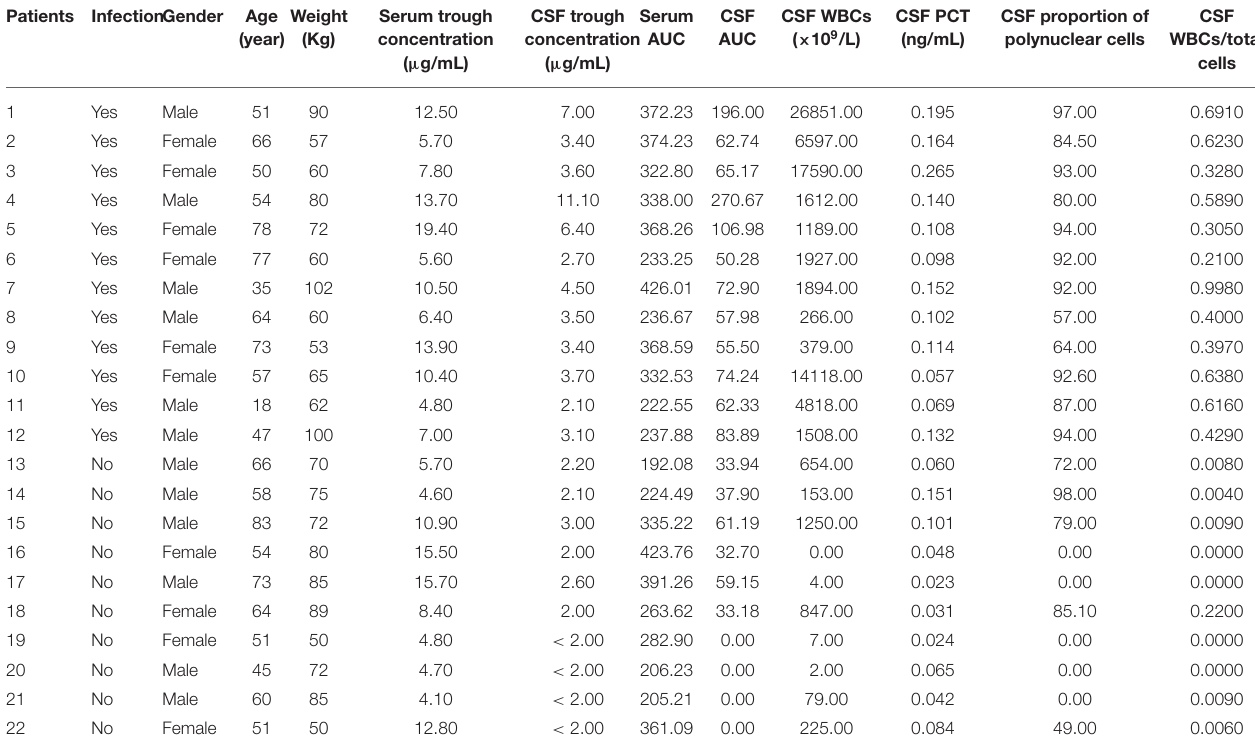
TABLE 1 | The demographics of these 22 patients. Patients InfectionGender Age